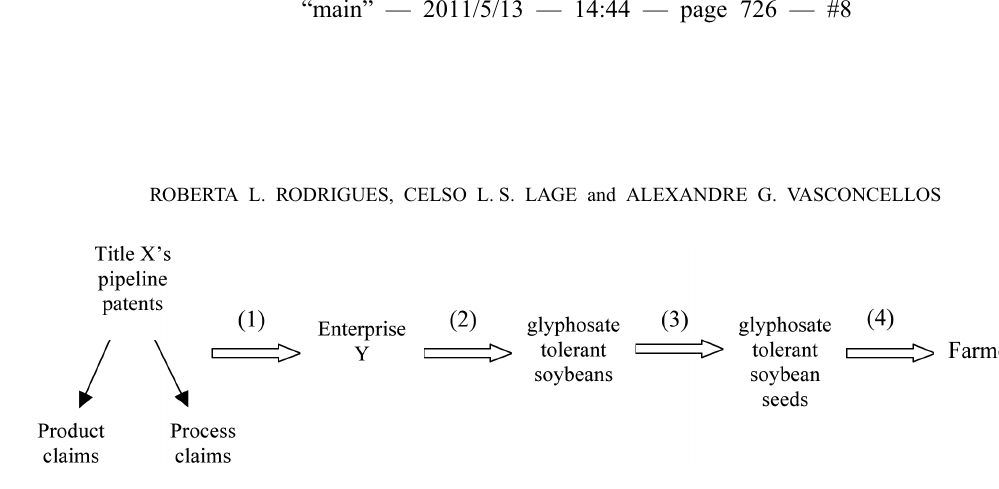
Fig. 1 – The scheme above demonstrates that the exhaustion of rights of title X’s pipeline patents, which is determined by Law no. 9.279/96, occurs when they are rewarded by trading, offering for sale or selling (1) these patented technologies – product and process claims – to Enterprise Y. After this, Enterprise Y is legally able to use (2) the patented glyphosate tolerance technologies to develop glyphosate tolerant soybeans. These plants can be intellectually protected solely with the Plant Variety Protection Law (Law no. 9.456/97) by the Enterprise Y, which will produce (3) glyphosate tolerant soybean seeds in amounts to sell (4) them to the farmers.